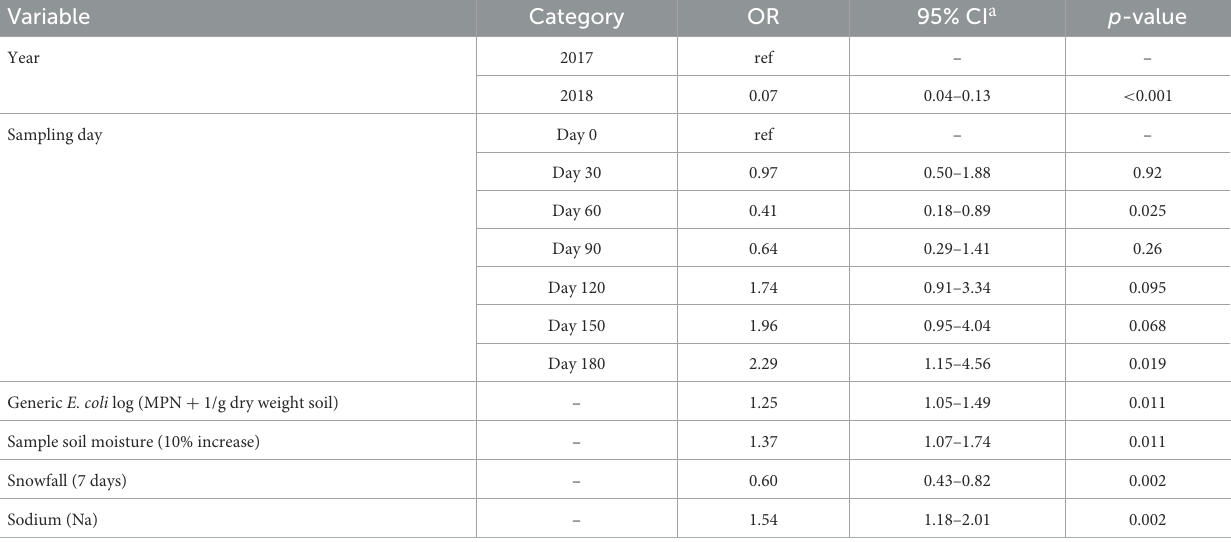
Keyvariablesfrommodel1wereforcedintothemodel.